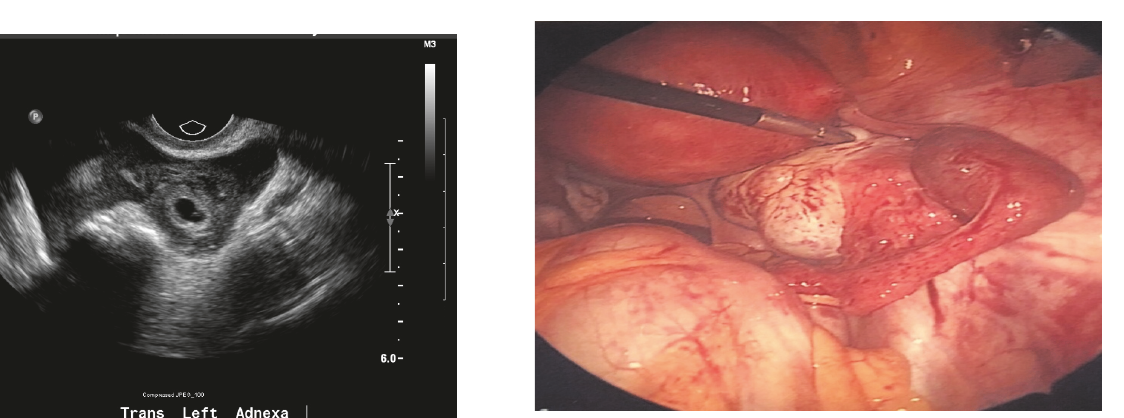
Figure 2: TVUS image of left adnexa with embryonic structures consistent with an ectopic pregnancy.